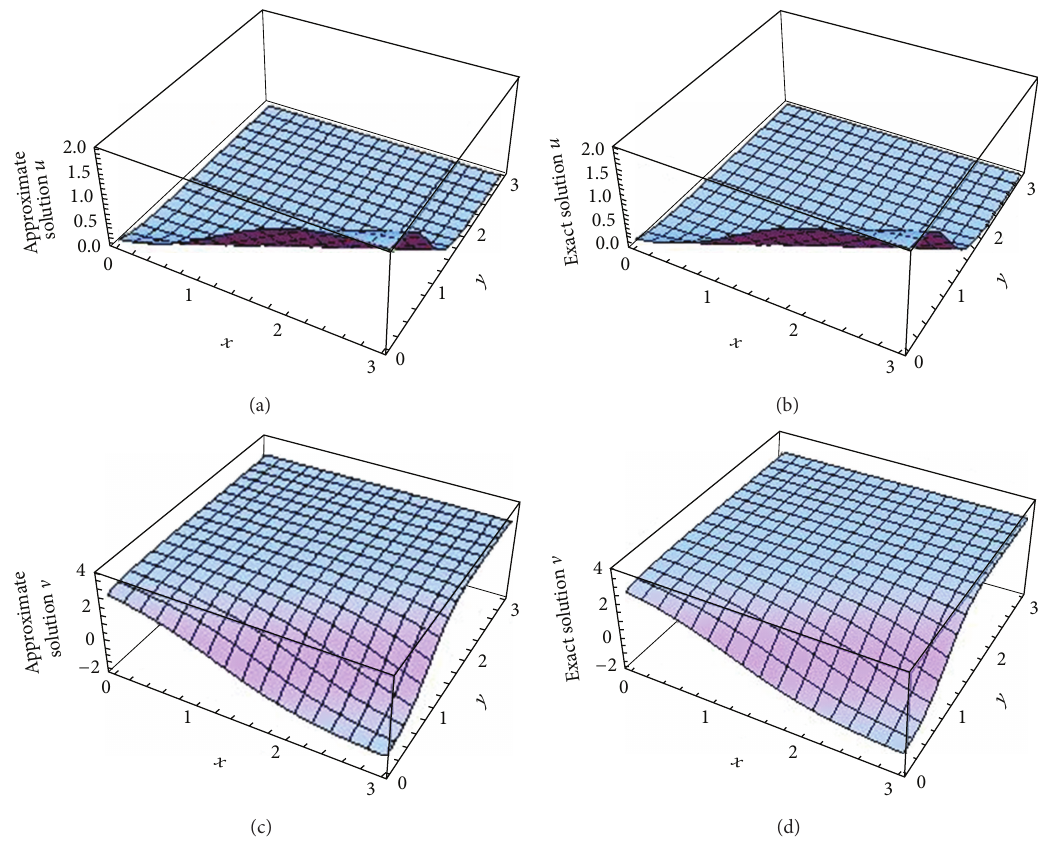
Figure 2: The surfaces show (a) the numerical approximate solution of 𝑢(𝑥,𝑦,0.1) , (b) the exact solution of 𝑢(𝑥,𝑦,0.1) , (c) the numerical approximate solution of V (𝑥,𝑦,0.1) , and (d) the exact solution of V (𝑥, 𝑦,0.1) when 𝛼 = 1 and 𝛽 = 1 .